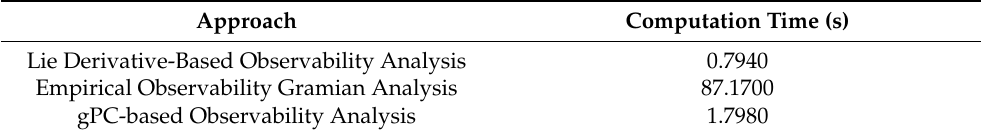
Table 2. Computation time of the three